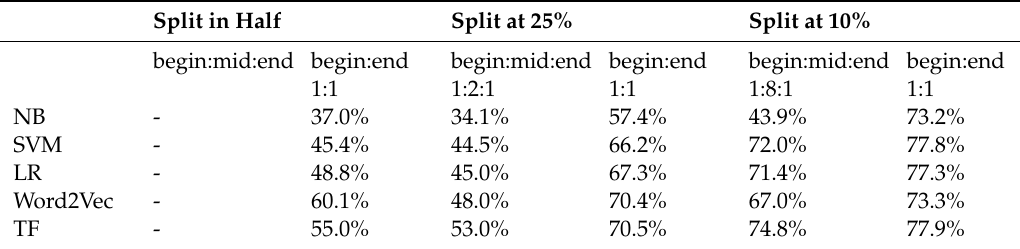
Table 5. Mean accuracy of classifiers for di ff erent splits—West Africa.